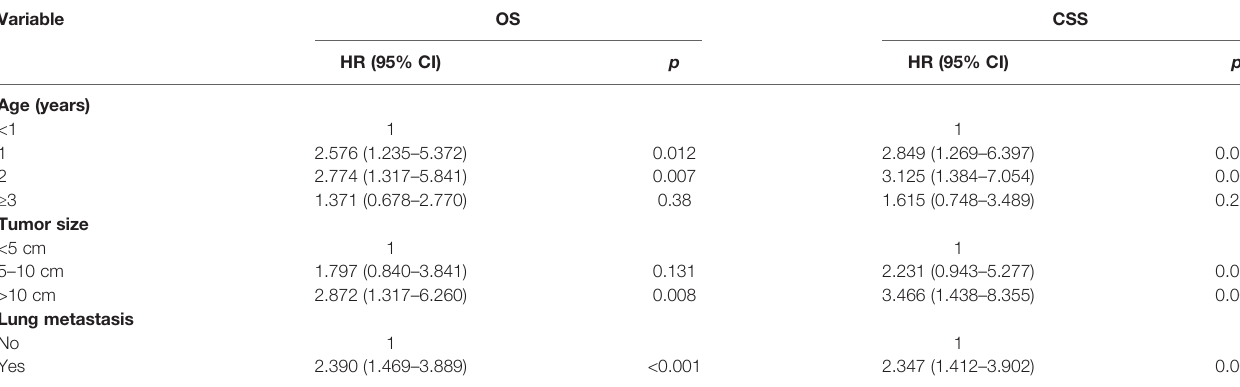
TABLE 3 | Multivariate Cox analysis of variables in NB patients with bone metastasis at diagnosis. Variable OS